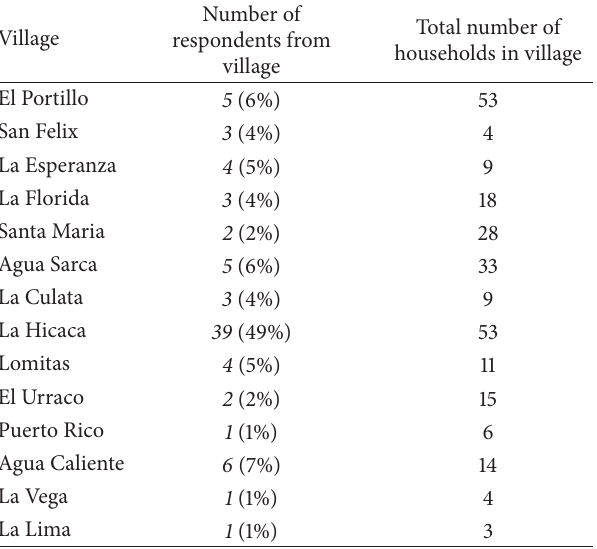
Table 1: Survey respondents and village of